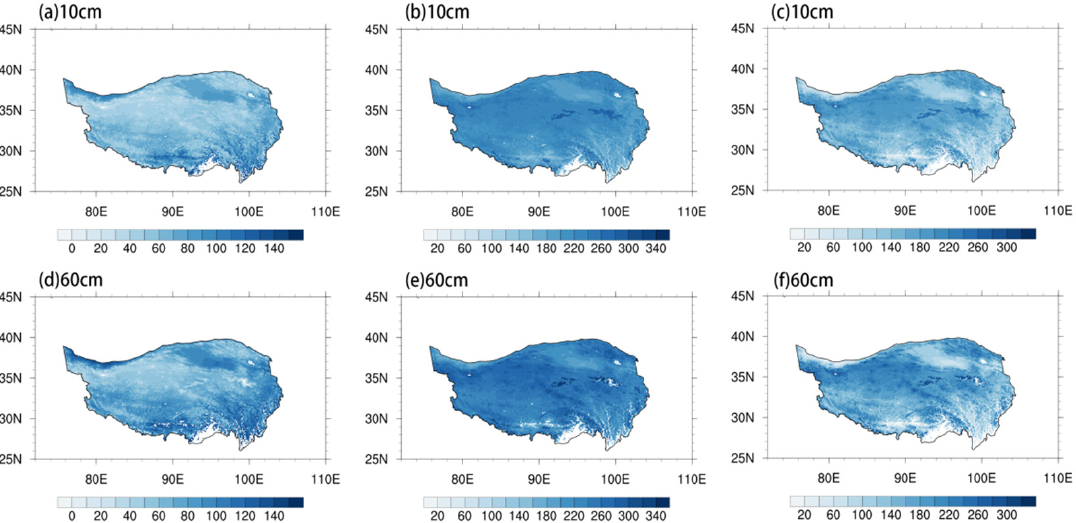
Figure 9. Spatial distributions of multi-year means of the freezing date, thawing date, and freeze–thaw duration for two soil depths from 1980 to 2016 (units: days after 1 September ( a , b , d , e ); days ( c , f )). ( a ) Freezing date of soil at 10 cm depth. ( b ) Thawing date of soil at 10 cm depth. ( c ) Freeze–thaw duration of soil at 10 cm depth. ( d ) Freezing date of soil at 60 cm depth. ( e ) Thawing date of soil at 60 cm depth. ( f ) Freeze–thaw duration of soil at 60 cm depth. Table 1. Multi-year means of soil freeze–thaw processes at different soil depths.